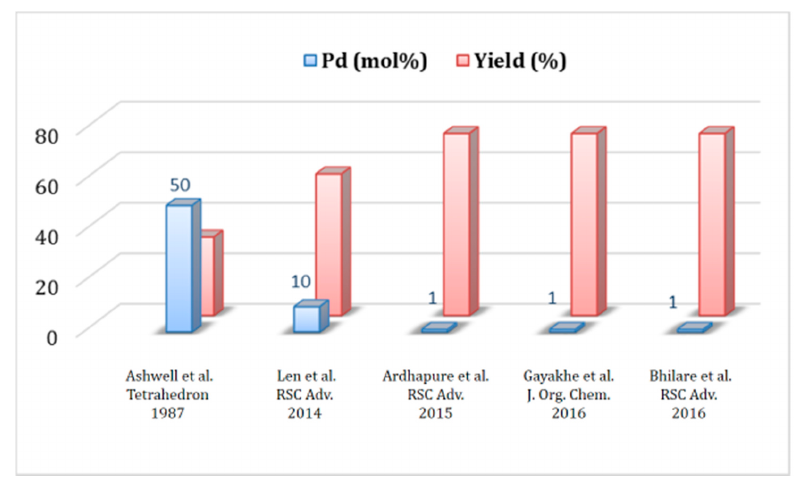
Figure 6. Comparative chart for the synthesis of BVDU.